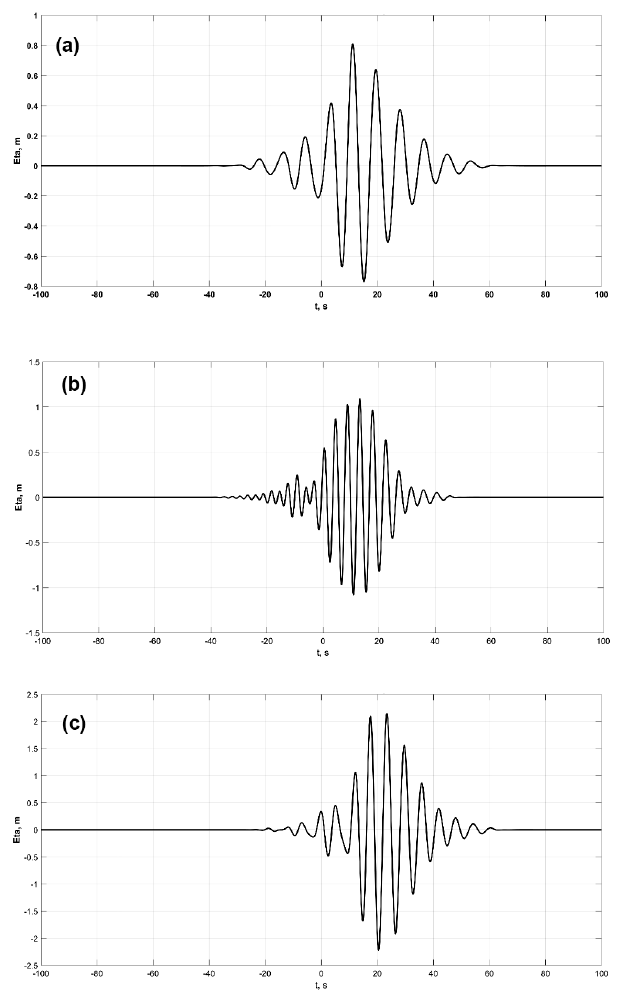
Figure 13. Imposed surface elevation at the generation bound- ary: (a) wave no. 1, (b) wave no. 3, (c) wave no. 4.